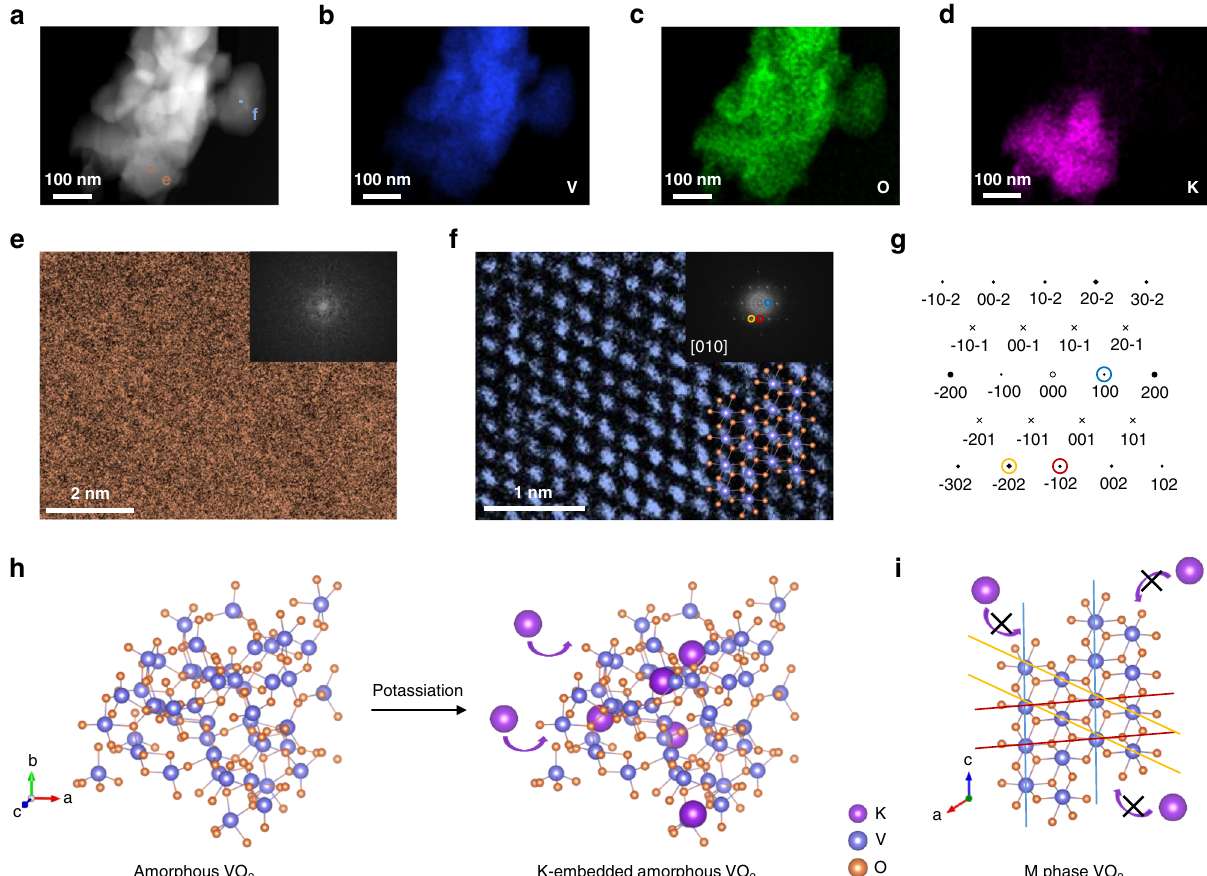
Fig.1|InvestigationofpotassiumstoragecapabilityofVO 2 indifferentphases. a HAADF-STEM image of VO 2 (M) with corresponding elemental mapping of ( b ) V, ( c ) O, and ( d ) K. e , f The HRTEM images of the tan and dark blue squared areas in